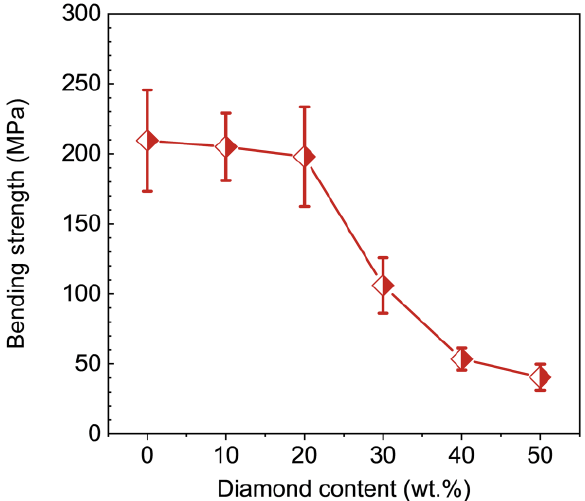
Figure 7. Bending strength of the TiO 2 -diamond composites as a function of the diamond content.